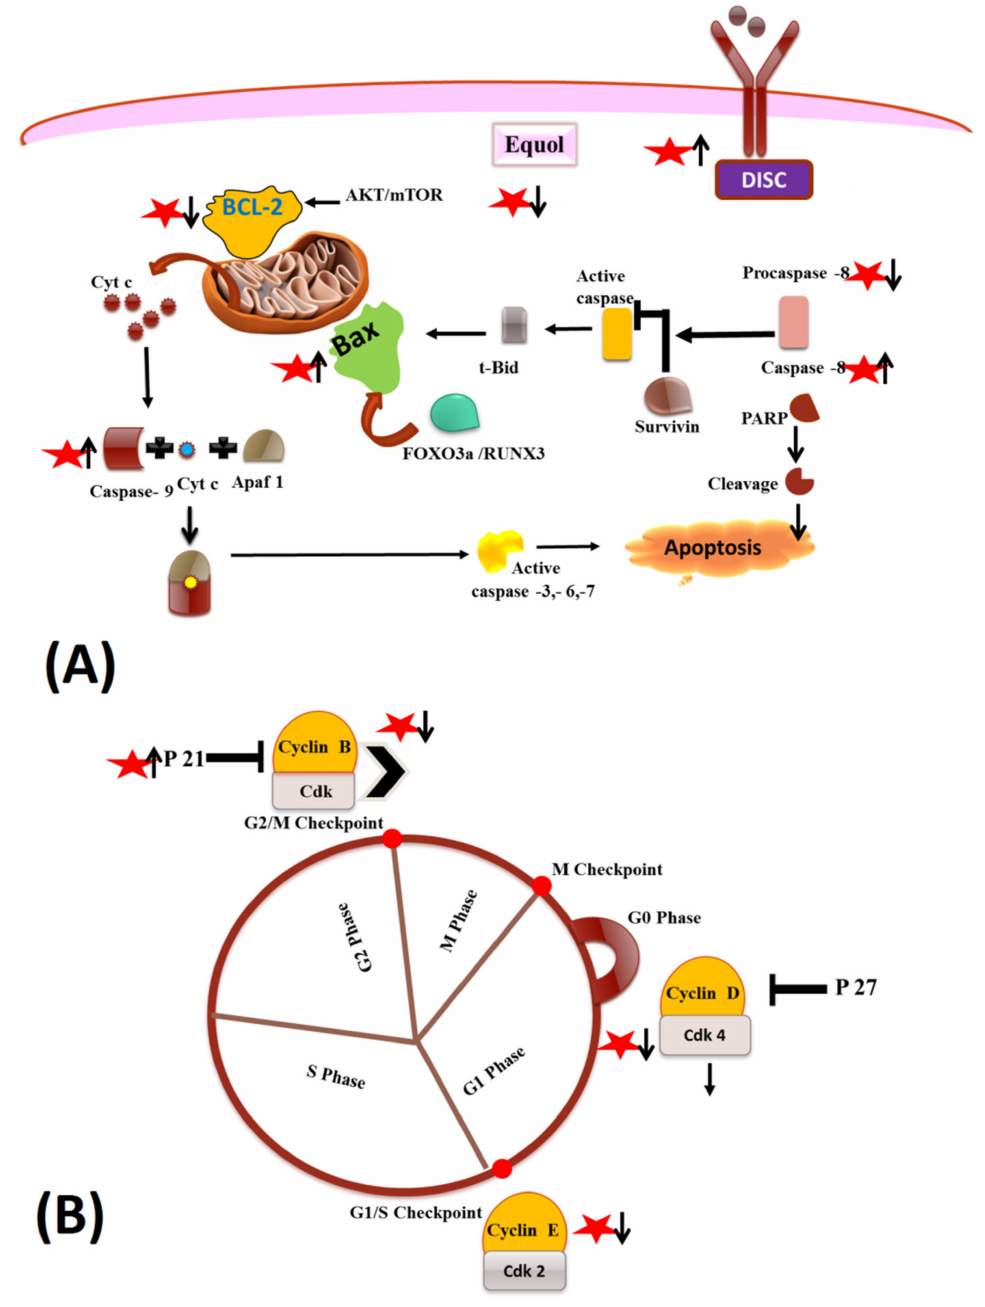
Figure 2. ( A ) The effect of equol (represented as red star) on apoptosis. ( B ) The effect of equol on regulation of cell cycle